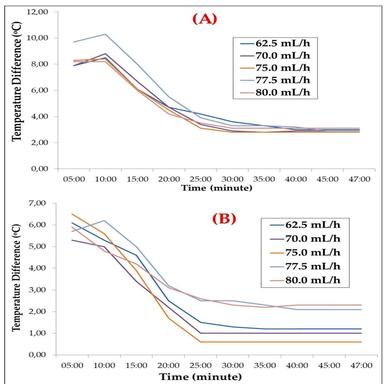
Surface temperature differences for various feeding rates of nanocapsule-doped composite yarn with different nanocapsule concentrations: A) 3 % capsule concentration, and B) 9 % capsule concentration.